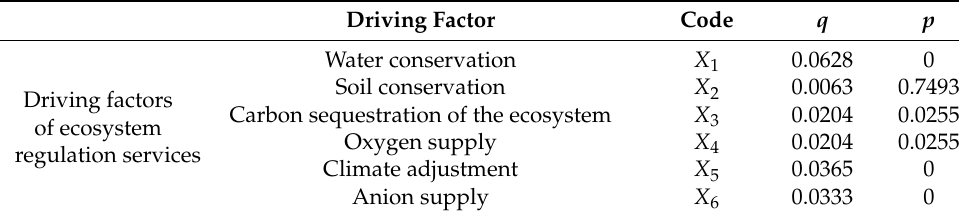
Table 5. Differentiation and factor detection results.